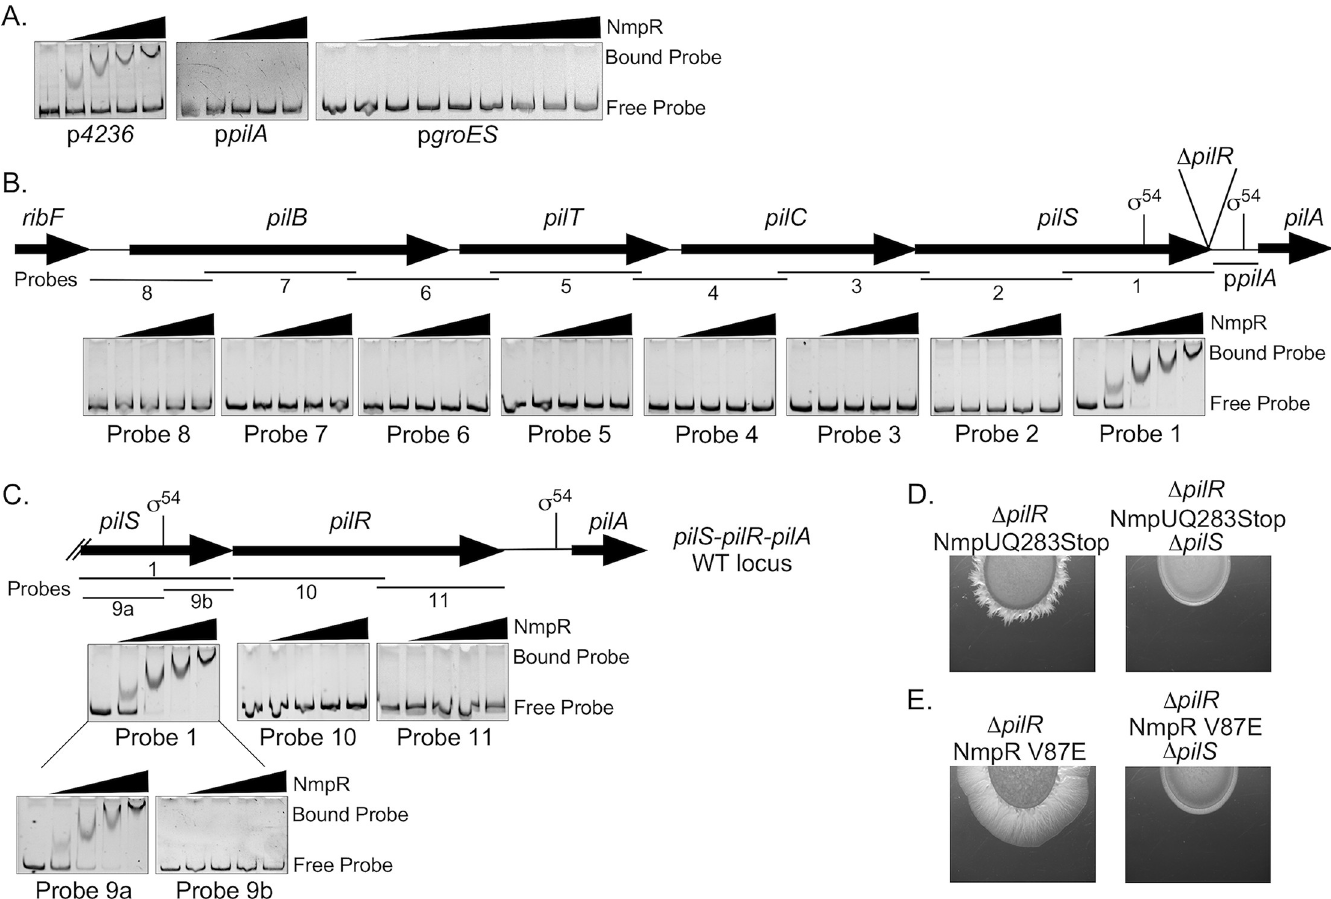
Fig 8. NmpR binds specific promoters upstream of its own putative operon and upstream of pilR . (A) NmpR binds to the promoter regions of mxan_4236 (referred to elsewhere as p Nat —585 bp upstream of mxan_4236 ) (See also Fig 2A), but not to that of the pilA promoter (217 bp upstream of pilA ) or p groES (referred to elsewhere as pHigh—623 bp upstream of mxan_4894 , groES ). (B) NmpR binds specifically to a probe encompassing 800 bp upstream of pilR that includes a putative σ 54 in the pilS open reading frame. The σ 54 in the p pilA known to be utilized by PilR in a wild-type genomic context is also indicated. (C) Finally, NmpR binds only to a region within pilS upstream of the putative σ 54 binding site. The sequence containing this NmpR-dependent promoter is necessary for the restored motility in the suppressor strains because deletion of pilS returned these strains to a non-motile phenotype (D and E). All shift assays depicted contained 200 fmol of DNA probe and increasing quantities of NmpR (0, 2, 8, 16, and 32 pmol, left to right). The exception is the p groES shift that includes the same quantities of NmpR but with a broader range (0, 2, 4, 8, 12, 16, 20, 24, 32 pmol, left to right). All gene lengths and locations, as well as probe length and location are to